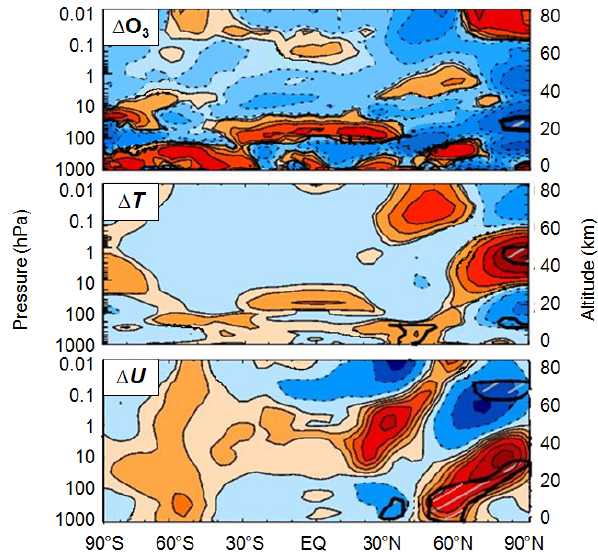
Fig. 6. Monthly mean zonal mean effects of GCRs on ozone (O 3 ) , temperature ( T ) and zonal wind ( U) for the month of February. Red colors: increases; blue colors: decreases. Upper panel: effect on O 3 given in percent. Contour levels: − 5, − 2, − 1, − 0.5, − 0.1, 0, 0.1, 0.5, 1, 2, 5%. Center panel : effect on T given in Kelvin. Contour levels: − 5, − 3, − 2, − 1, − 0.5, − 0.1, 0, 0.1, 0.5, 1, 2, 3, 5 K. Lower panel : effect on U given inms − 1 . Contour levels: − 5, − 3, − 2, − 1, − 0.5, − 0.1, 0, 0.1, 0.5, 1, 2, 3, 5ms − 1 . Hatched areas (marked by thick black contours) show 95% statistical